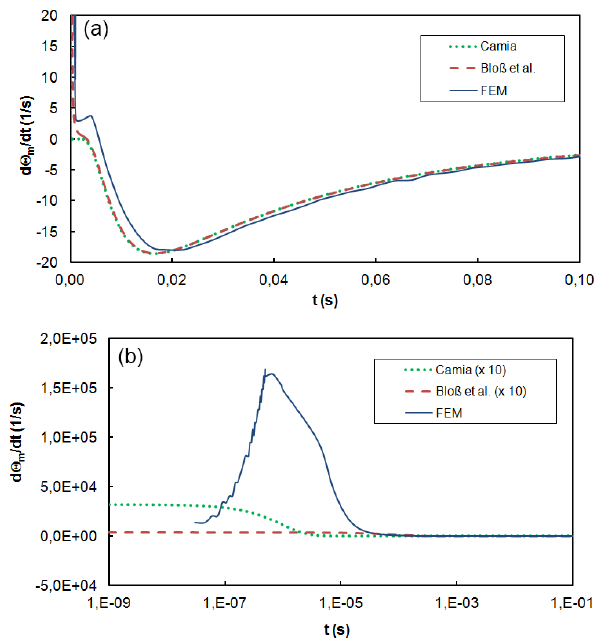
Figure 5. Time derivative of the mean temperature (proportional to the pyroelectric current) within a PZT plate, determined by three different models (cf. Sect. 2.2) with (a) linear and (b) logarithmic time axis. In (b) the values of the models of Camia (1967) and Bloß et al. (2000) were magnified by a factor of 10.